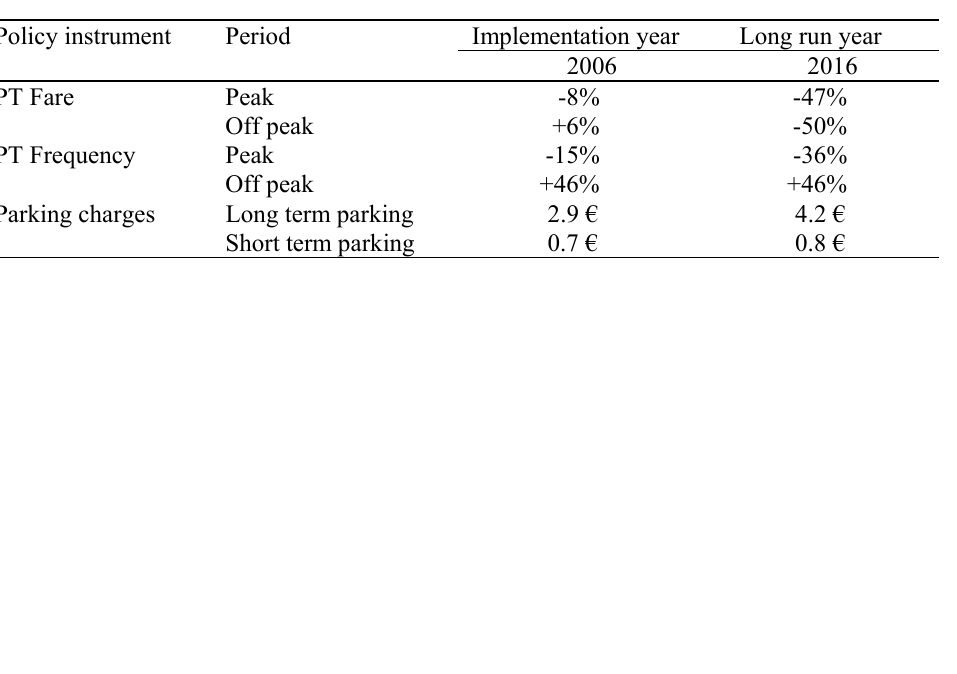
Table 1: Policy instrument combination resulting from the optimisation of a constrained objective function